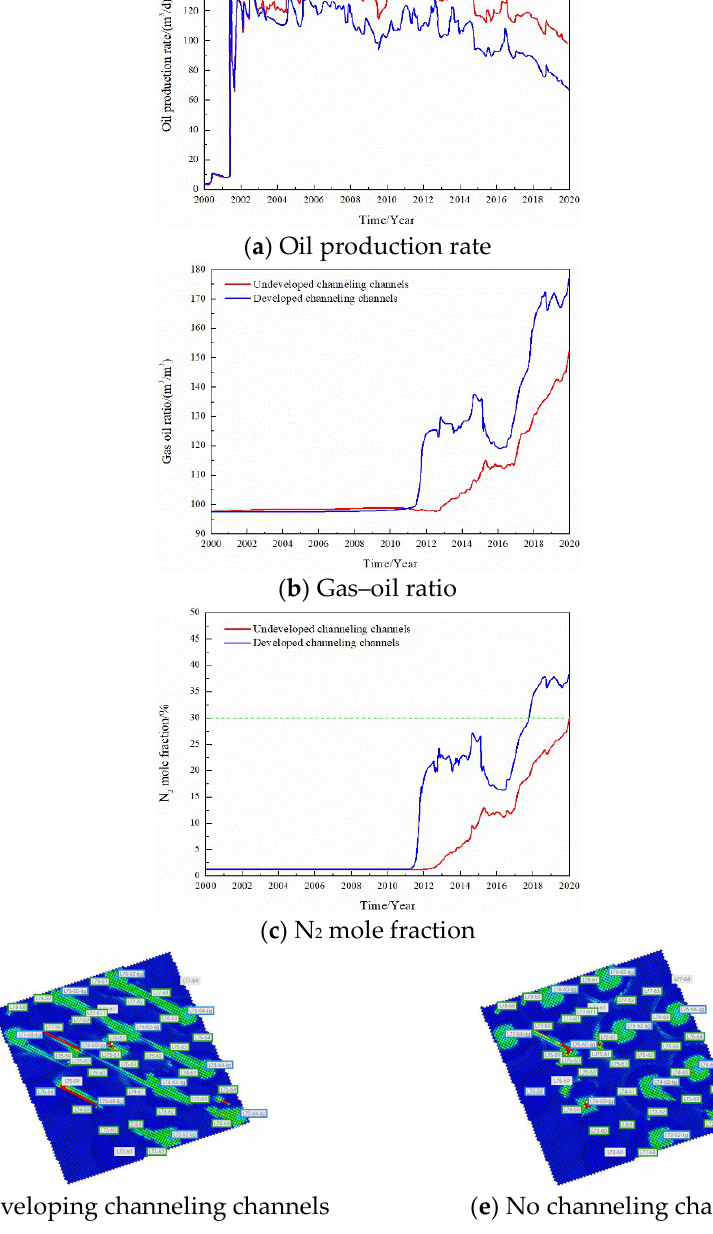
Figure 7. Effect of the channeling channel on the dynamic production performance.